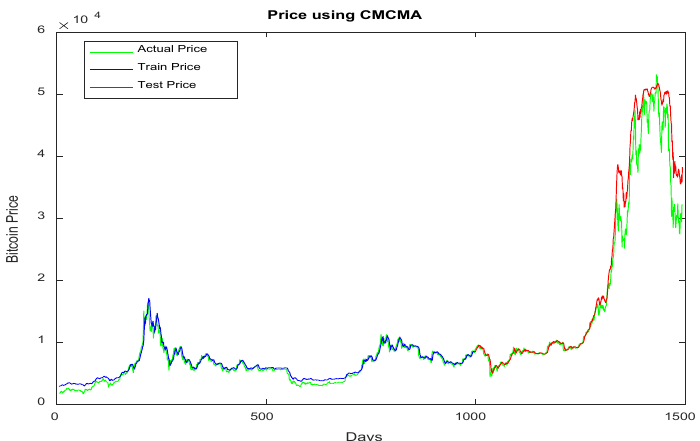
Figure 5. Bitcoin prices using CMCMA for BTC/EUR dataset.